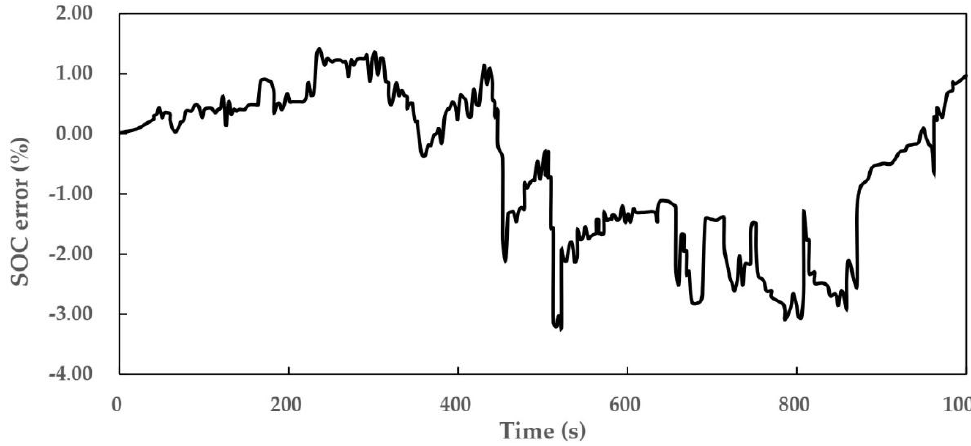
Figure 8. Error between the SOC estimated value and the actual value under BBDST operating conditions.